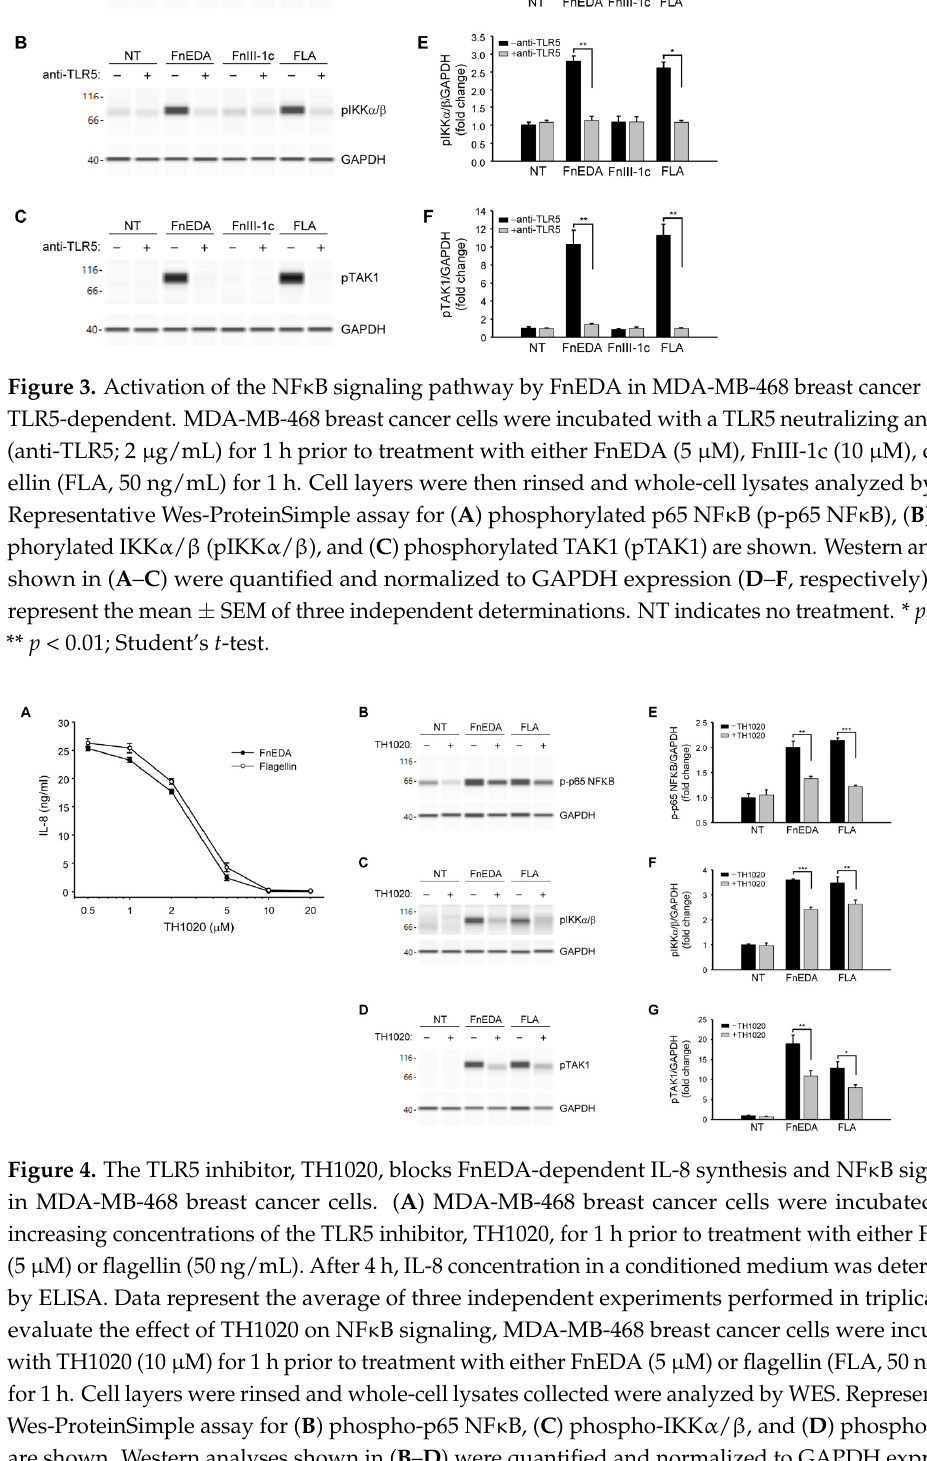
Figure 4. The TLR5 inhibitor, TH1020, blocks FnEDA-dependent IL-8 synthesis and NF κ B signaling in MDA-MB-468 breast cancer cells. ( A ) MDA-MB-468 breast cancer cells were incubated with increasing concentrations of the TLR5 inhibitor, TH1020, for 1 h prior to treatment with either FnEDA (5 µ M) or flagellin (50 ng/mL). After 4 h, IL-8 concentration in a conditioned medium was determined by ELISA. Data represent the average of three independent experiments performed in triplicate. To evaluate the effect of TH1020 on NF κ B signaling, MDA-MB-468 breast cancer cells were incubated with TH1020 (10 µ M) for 1 h prior to treatment with either FnEDA (5 µ M) or flagellin (FLA, 50 ng/mL) for 1 h. Cell layers were rinsed and whole-cell lysates collected were analyzed by WES. Representative Wes-ProteinSimple assay for ( B ) phospho-p65 NF κ B, ( C ) phospho-IKK α / β , and ( D ) phospho-TAK1 are shown. Western analyses shown in ( B – D ) were quantified and normalized to GAPDH expression ( E – G , respectively). Data represent the mean ± SEM of three independent determinations. NT indicates no treatment. * p < 0.05; ** p < 0.01; *** p < 0.001; Student’s t